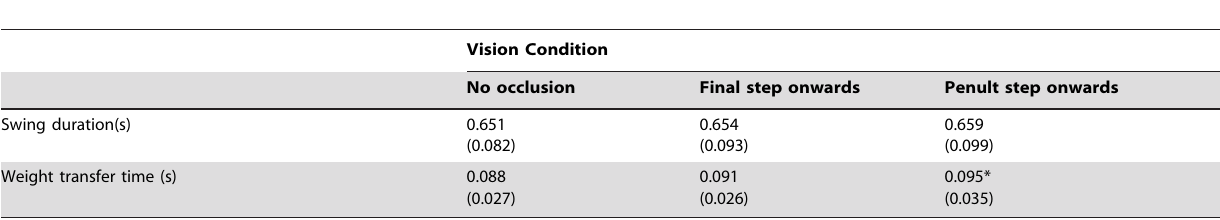
Table 2. Group mean ( 6 1 SD) temporal parameters for the full vision and lvf occlusion